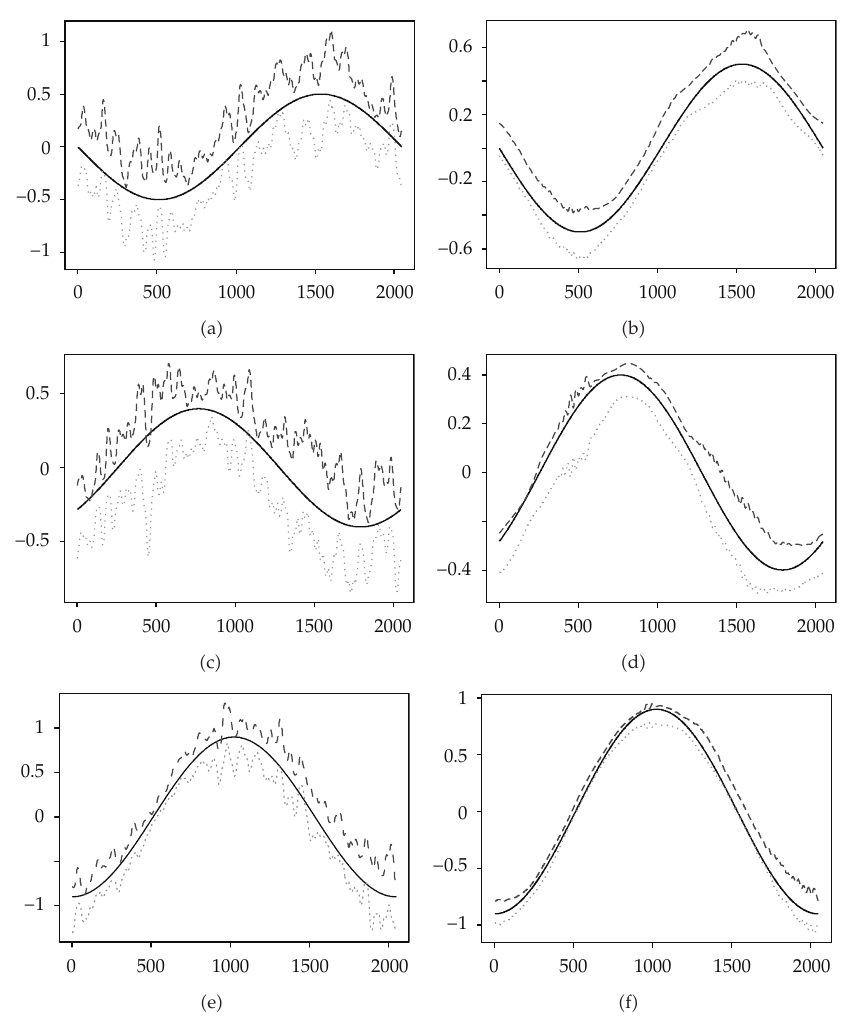
Figure 4: Example 5.1: Bootstrap 95% confidence regions for linear estimators, (cid:5) a (cid:6) , (cid:5) c (cid:6) , and (cid:5) e (cid:6) and nonlinear estimators, (cid:5) b (cid:6) , (cid:5) d (cid:6) , and (cid:5) f (cid:6) , with true curves